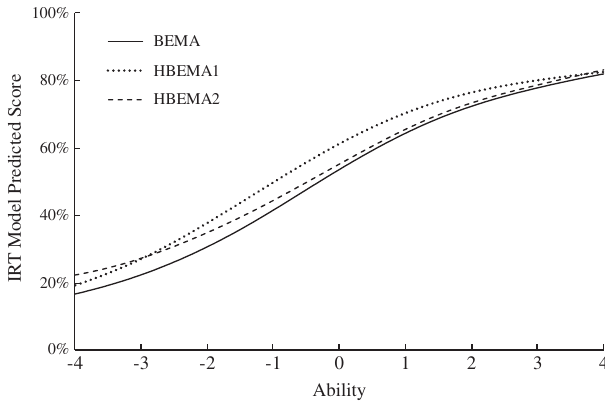
FIG. 3. Test characteristic curves (TCCs) of the two HBEMAs and the